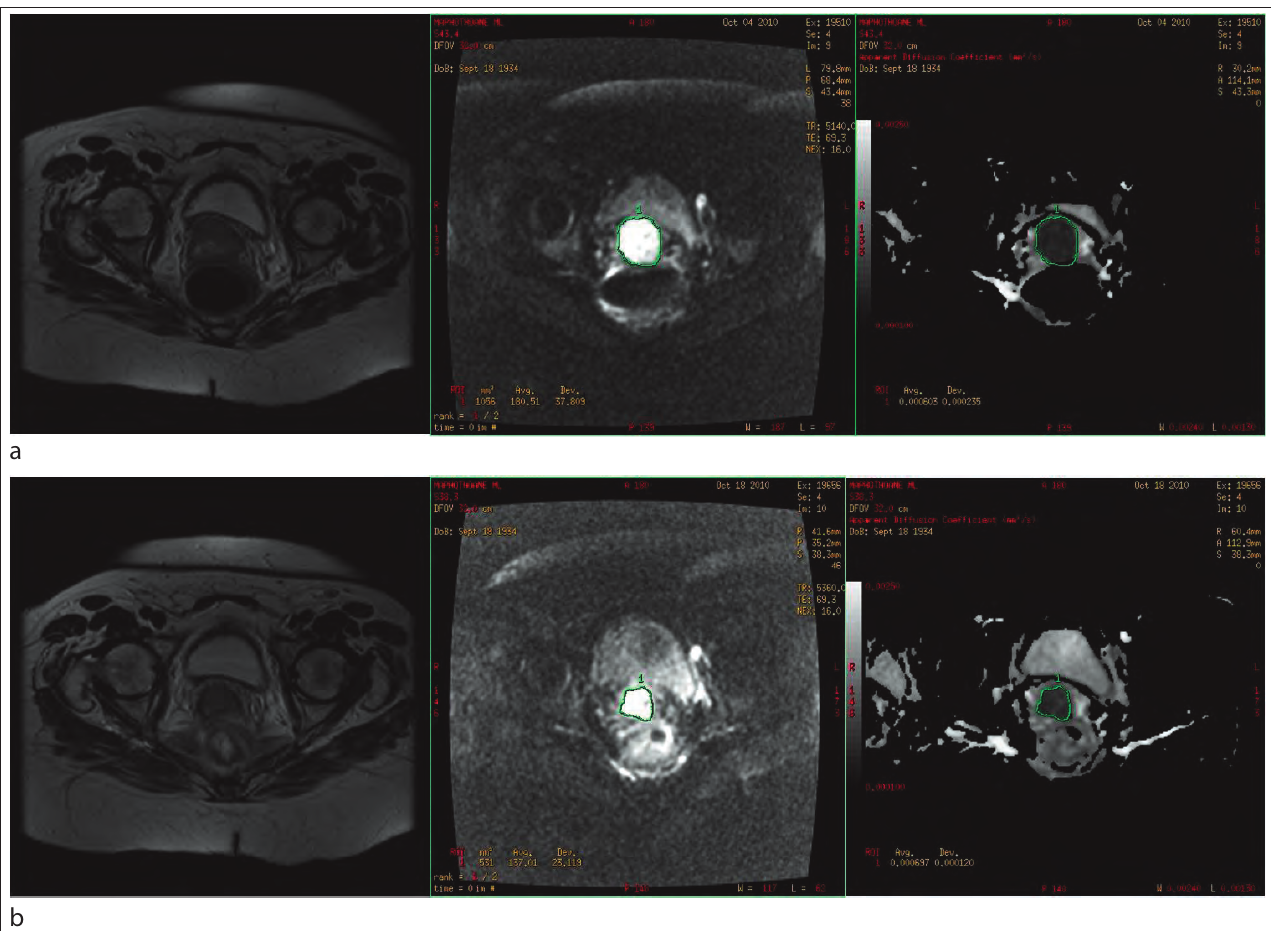
Fig. 1. Pelvic axial MRI of a patient diagnosed with carcinoma of the cervix. (a) Pre-treatment study. (b) Images obtained 14 days after the onset of treatment. Sequences from left to right are T2, DWI and ADC.